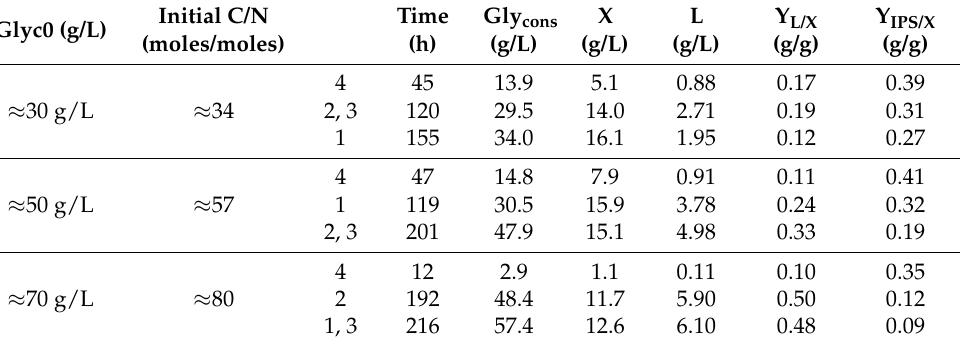
Table 3. Quantitative data of Cryptococcus curvatus strain ATCC 20509 deriving from kinetics on crude glycerol, in nitrogen-limited shake-flask cultures, in which various initial glycerol (Glyc0) concentrations ( ≈ 30, ≈ 50 and ≈ 70 g/L) and the same initial quantity of nitrogen (yeast extract at 1.0 g/L and peptone at 2.0 g/L) were imposed. Media with 3 different initial molar ratios C/N ( ≈ 34, ≈ 57 and ≈ 80 moles/moles) were created. Four different points in the fermentations are represented: (a) when the maximum quantity of DCW (X, g/L) was observed; (b) when the maximum quantity of lipid per DCW (Y L/X , g/g) was observed; (c) when the maximum quantity of absolute lipid value (L, g/L) was observed; (d) when the maximum quantity of intra-cellular polysaccharides per DCW (Y IPS/X , g/g) was observed. Fermentation time (h) and quantity of glycerol consumed (Glyc cons , g/L) are also depicted for all the above-mentioned fermentation points. Culture condition: growth on incubation temperature T = 28 ◦ C. Each experimental point is the mean value of two measurements (SE < 15%).